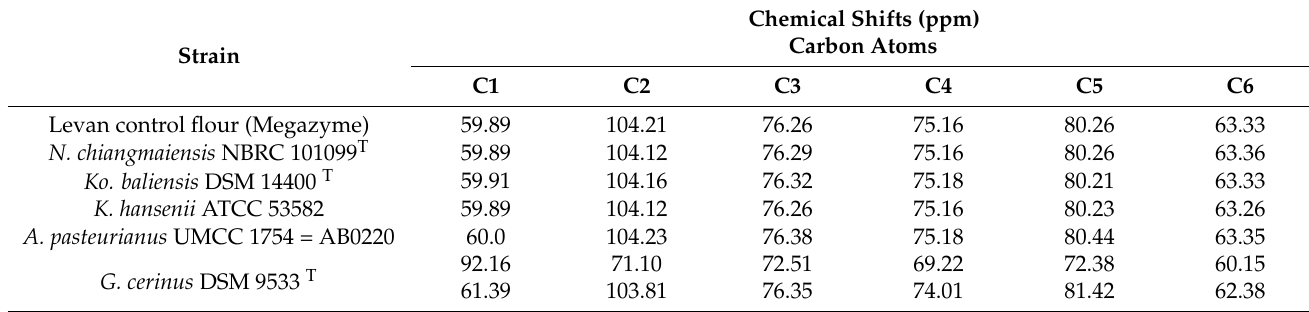
Figure 4. 13 C NMR spectra of levan produced by AAB strains cultured at 250 g/L sucrose concen- tration; ( a ) Levan control flour (Megazyme ® ) ( b ) N. chiangmaiensis NBRC 101099 T ; ( c ) Ko. baliensis DSM 14400 T ; ( d ) K. hansenii ATCC 53582; ( e ) A. pasteurianus AB0220; ( f ) G. cerinus DSM 9533 T . α‐ D ‐ glu ‐ Table 3. Chemical shifts of 13 C NMR for characterization of levan produced from AAB strains.